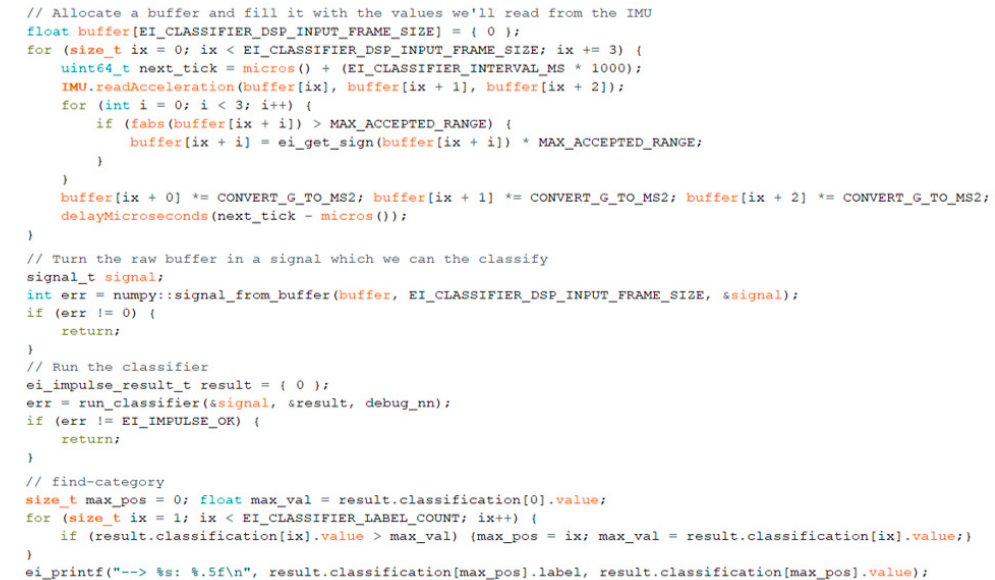
Figure A1. The software implementation details for the proposed system. The main parts of the code run on the ML-capable microcontroller.